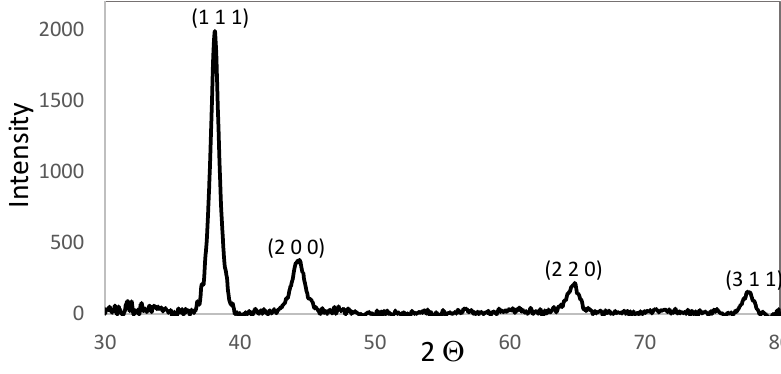
Figure 3. XRD pattern of AuNPs.